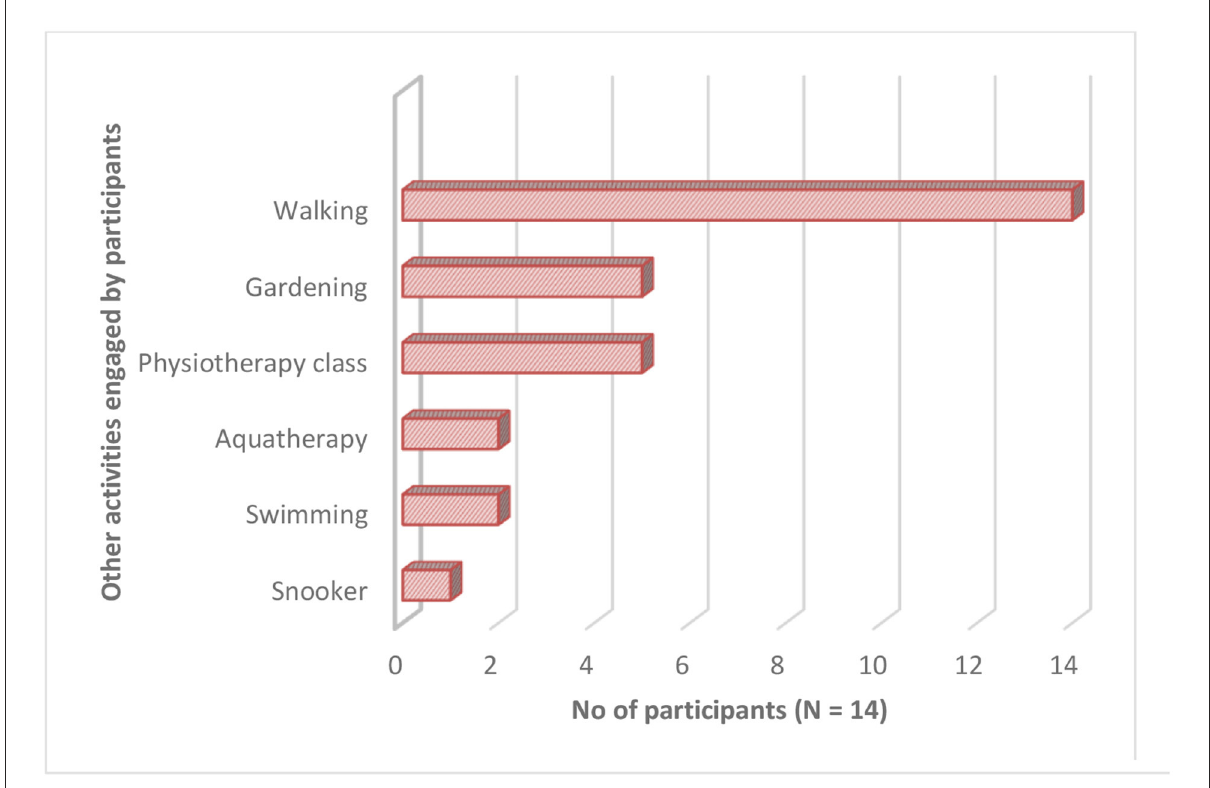
FIGURE3 Overview of other activities engaged by participants ( n =